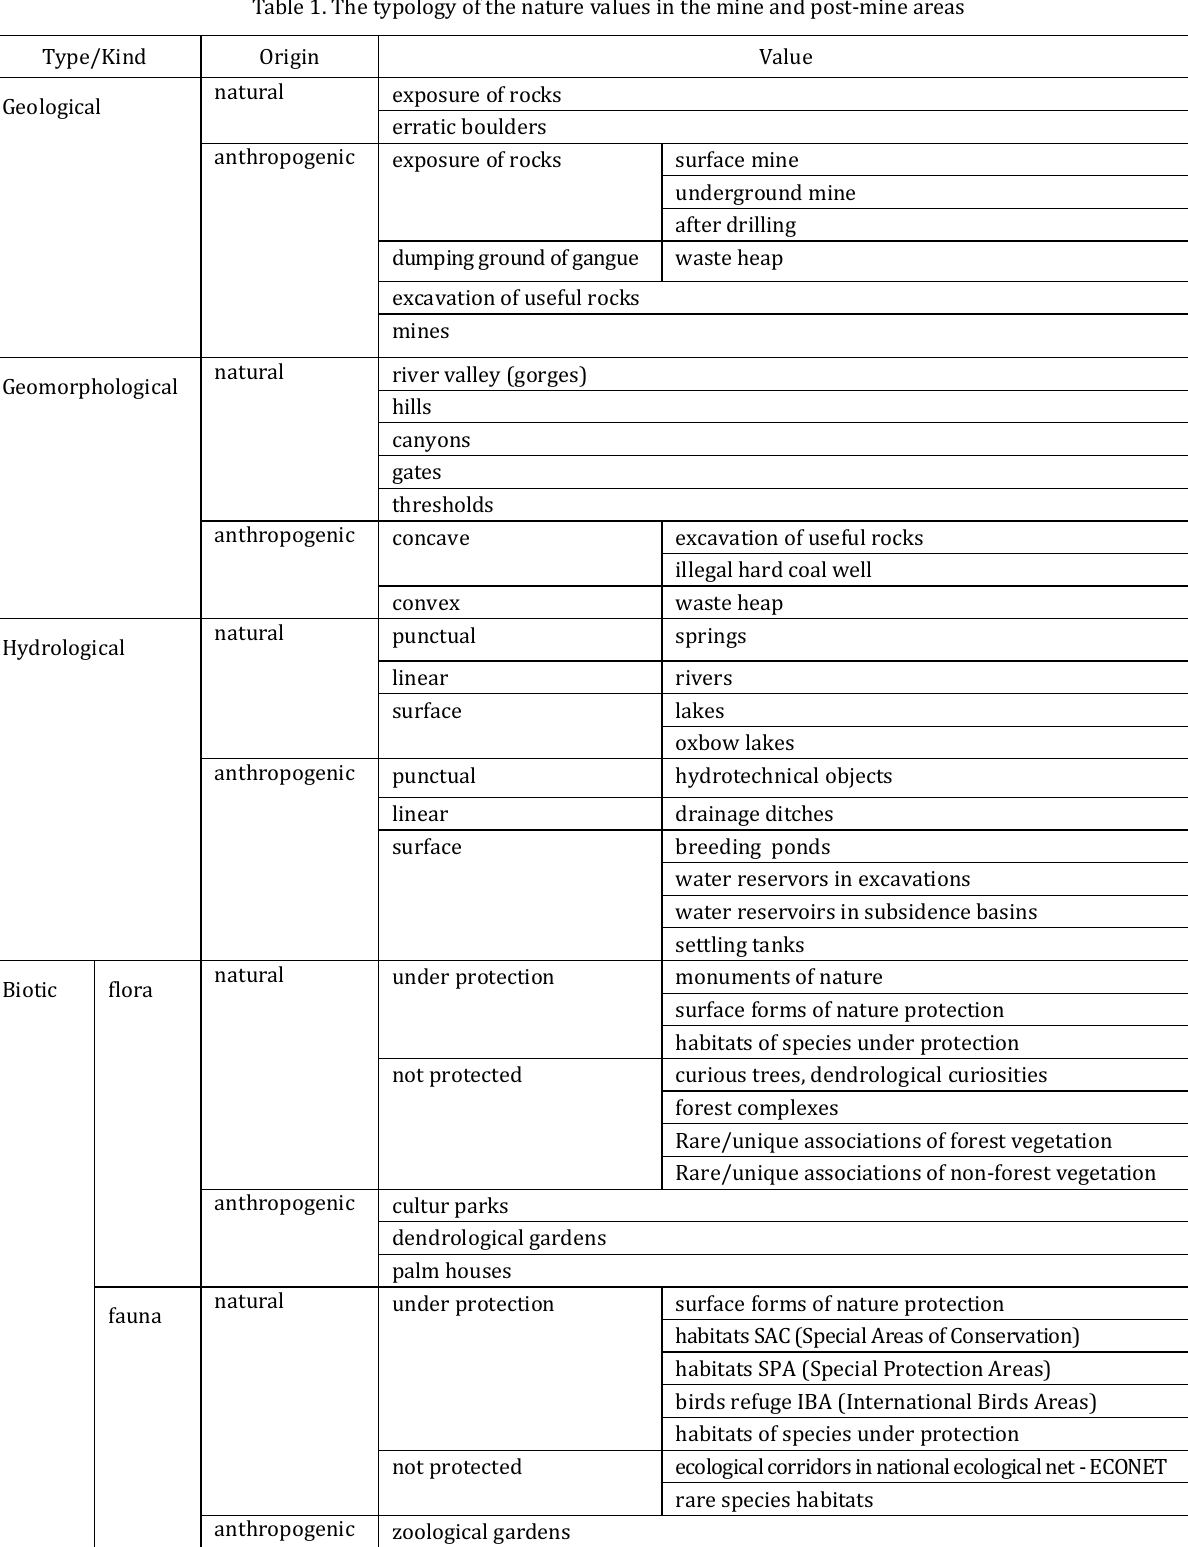
Table 1. The typology of the nature values in the mine and post-mine